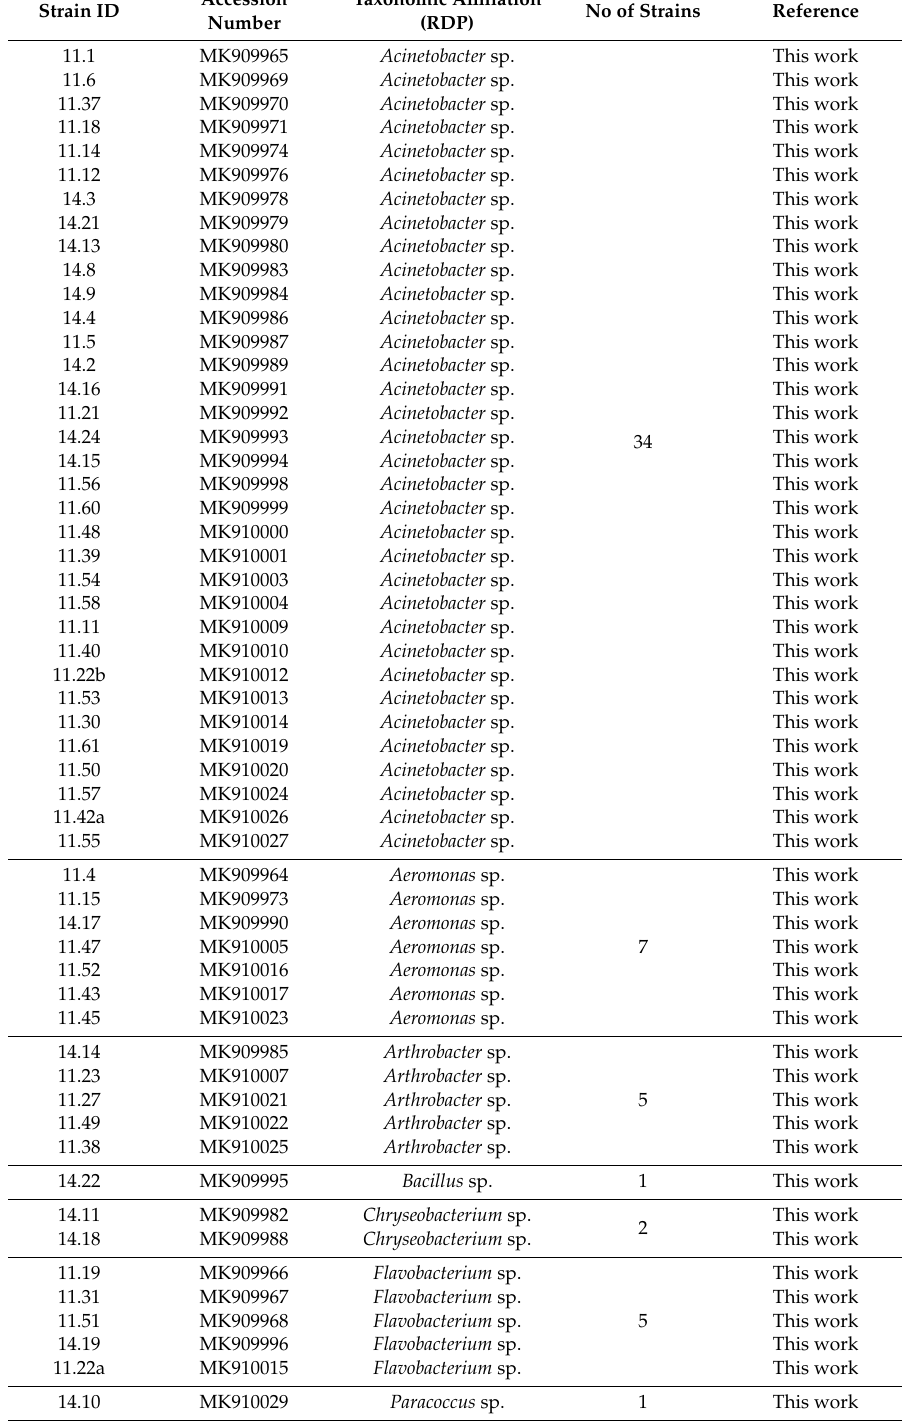
Table 2. List of bacterial strains used in this work. The accession number of 16S rRNA gene sequence of each strain is